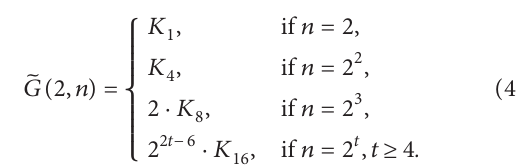
Figure 3: 􏽥 G ( 2 , 5 ) � 4 K